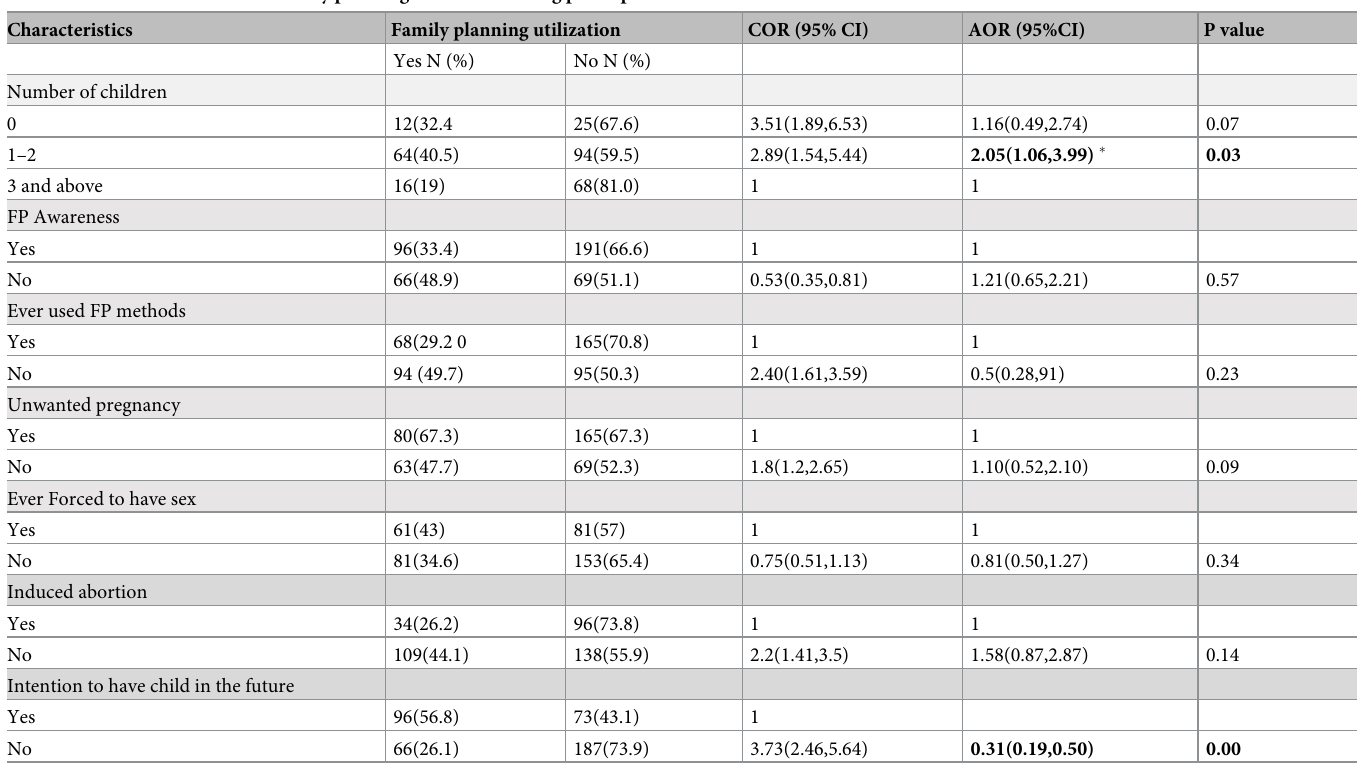
Table 4. Factors associated with family planning utilization among